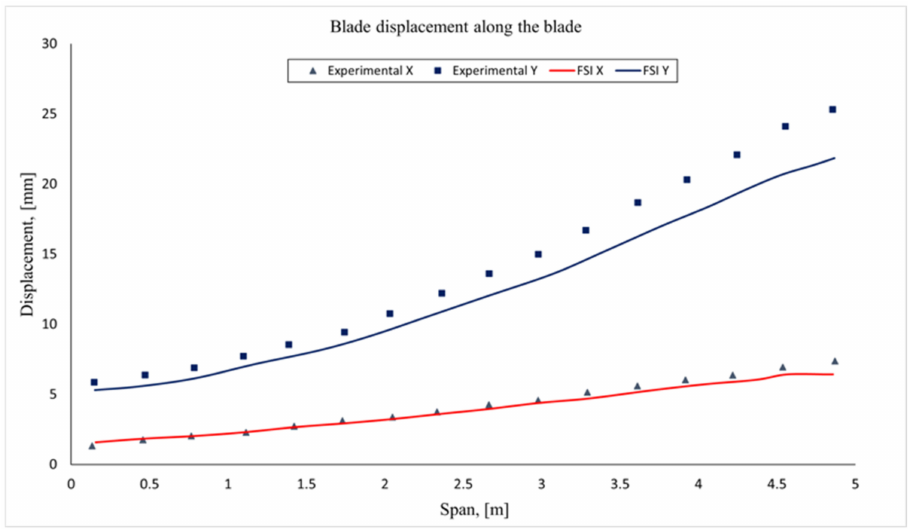
Figure 8. The comparison of the blade displacement in x and y direction along blade span in terms of experiment and FSI simulation.